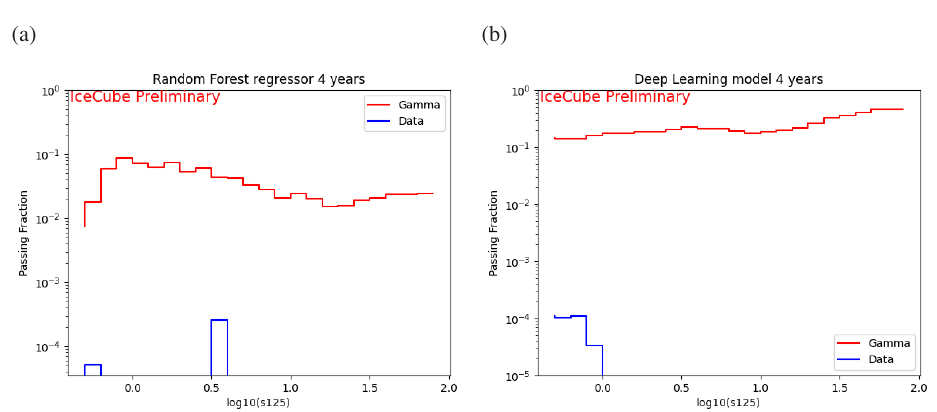
Figure 2: Passing fractions of gamma rays (red line) and data (blue line) as function of S 125 . The two di ff erent models investigated for the gamma-hadron separation are shown. Both use the same input features and have the selection cut set at 0.999. The period of time taken into account is from 2012 to 2015. The missing line in Data means a zero value, obtained on the test sample which counts 10.000 events per ∼